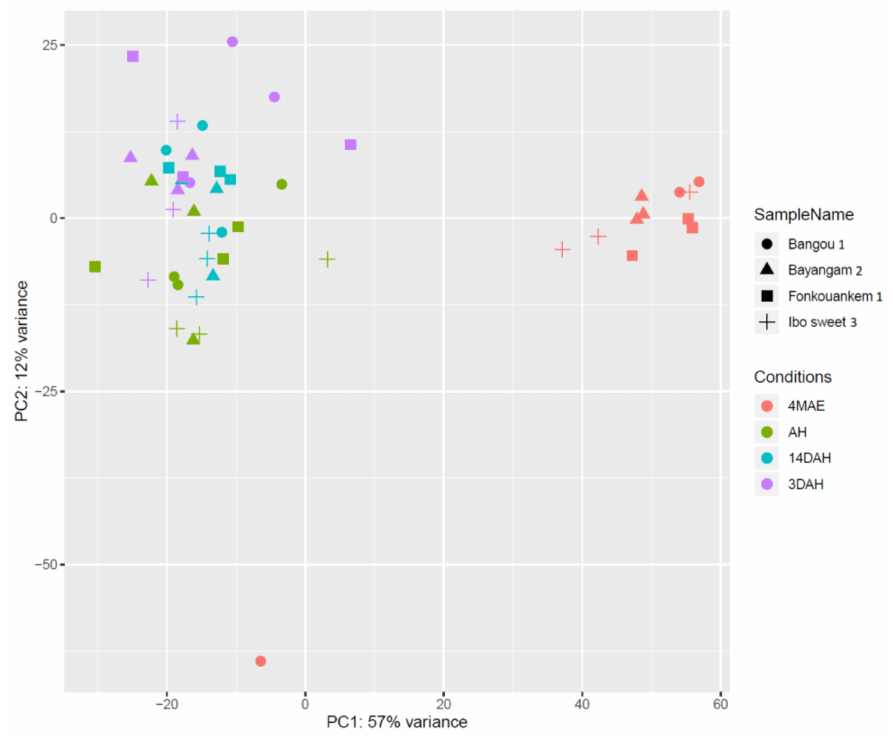
Figure 1. PCA plot of normalized counts using the variant stabilizing transformation (VST). Four D. dumetorum accessions (symbols) at four different sampling points (colors) are